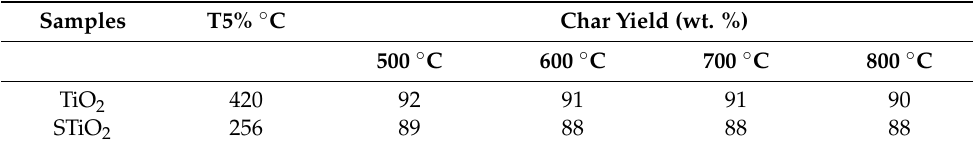
Table 1. Thermal properties of TiO 2 and STiO 2 from TGA analysis.